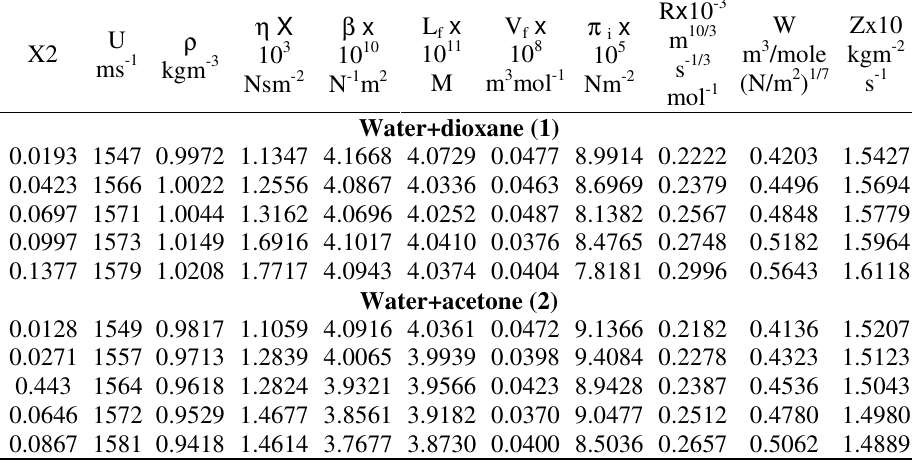
Table 1. Measured parameters for water + 1, 4 dioxane, benzene at 303